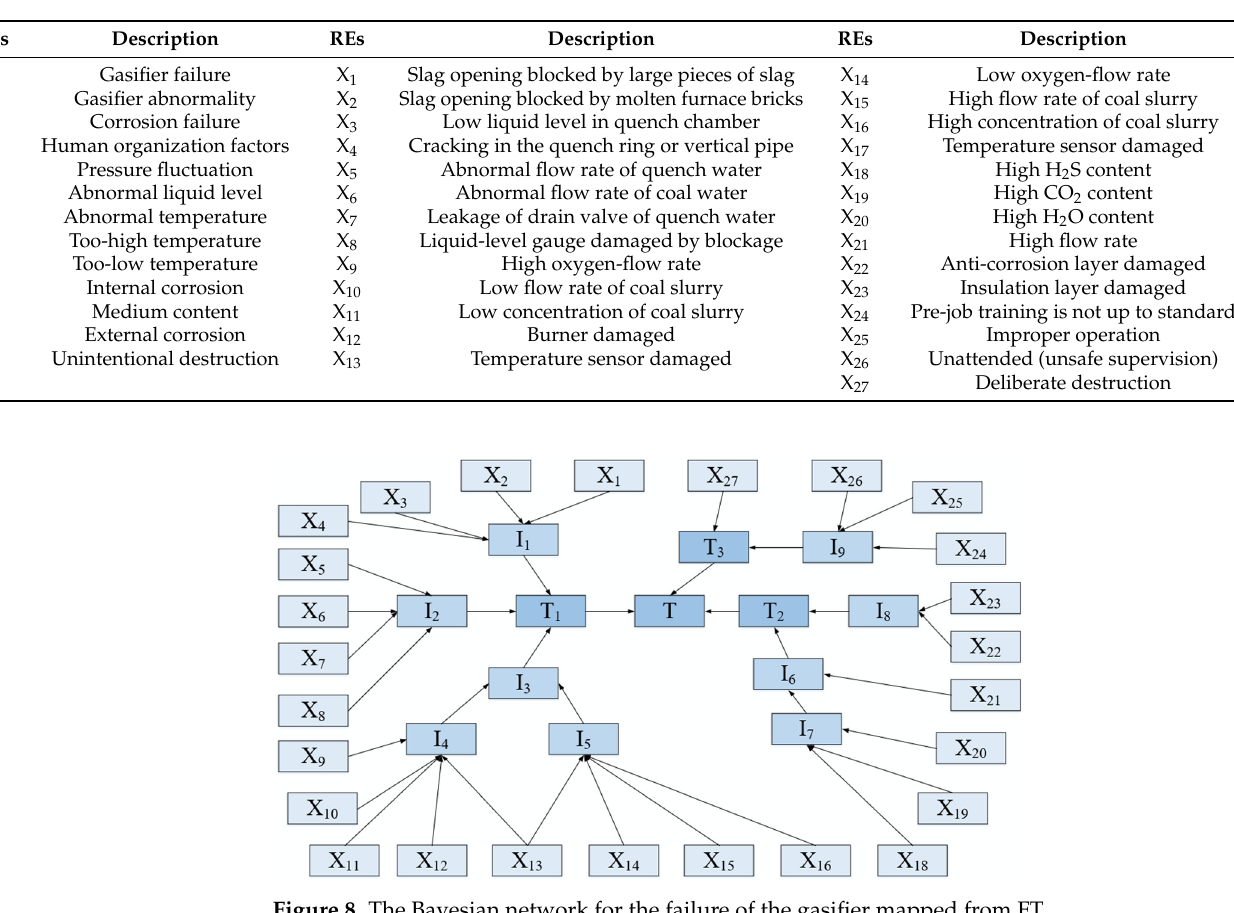
Table 5. Failure-probability rating of the coal gasifier.